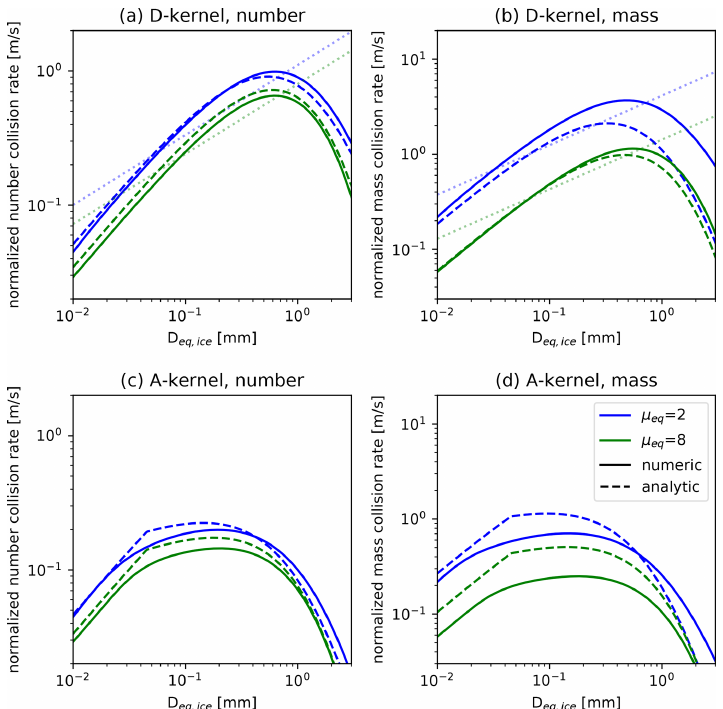
Figure B3. Numeric and analytic solution of the bulk collision rates for ice–ice (both column) collisions: (a, c) normalized number collision rate, (b, d) normalized mass collision rate, (a, b) D-kernel, (c, d) A-kernel.